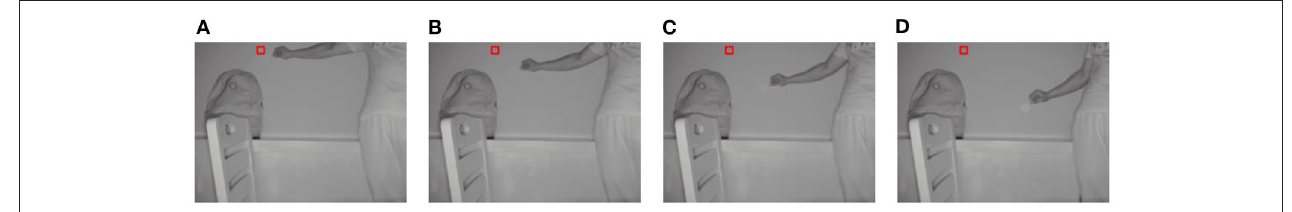
FIGURE 7 | Tracking results from the mean-shift algorithm. (A) The 10th frame; (B) the 30th frame; (C) the 50th frame; (D) the 80th frame.